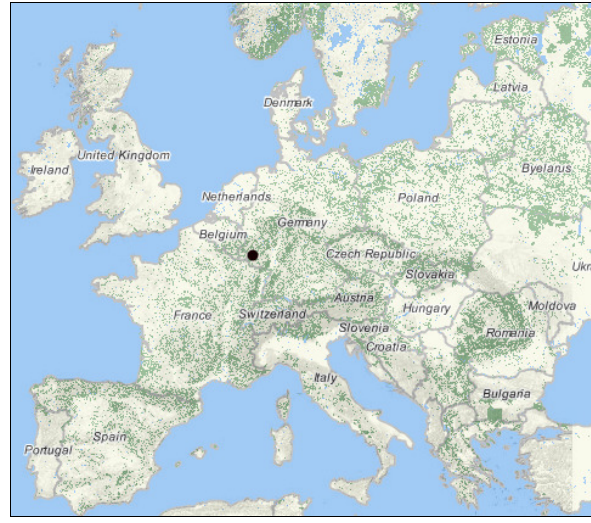
Figure 1. Location of the study area